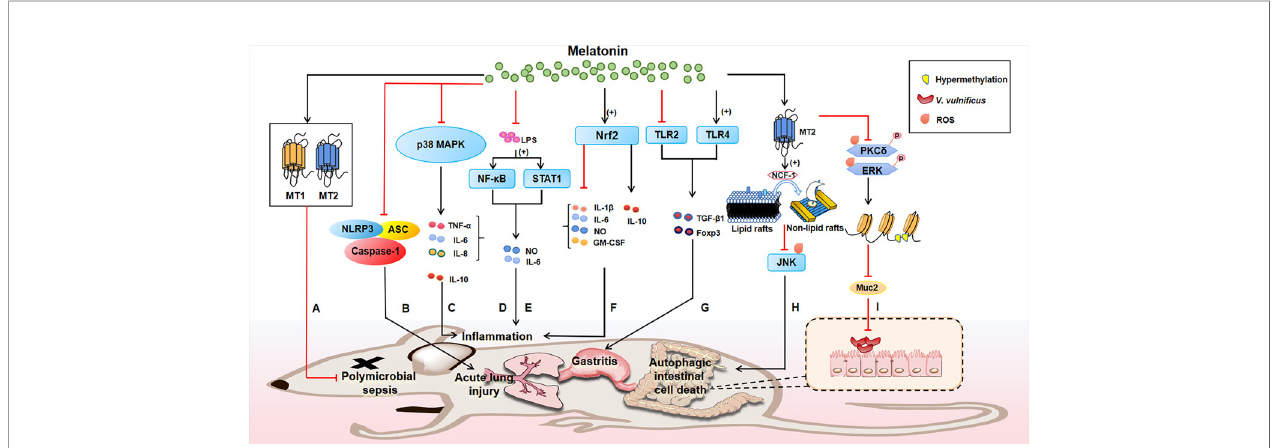
FIGURE 2 | The bacteriostatic mechanisms of melatonin in animals. Melatonin receptors (e.g., MT1 and MT2) play a great role in mediating the functions of melatonin. Melatonin reduces polymicrobial sepsis through MT1 and MT2, thus improving the survival rate of mice (A) ; notably, the mechanisms whereby melatonin exerts bacteriostatic action in vivo are tightly associated with the immune responses, for instance, melatonin inhibits NLRP3 in fl ammasome to alleviate acute lung injury (B) ; melatonin reduces pro-in fl ammatory cytokines, increases anti-in fl ammatory cytokines and improves survival through p38MAPK signaling pathway (C) ; melatonin blocks LPS-induced activation of NF- k B (D) and STAT1 (E) , thus inhibiting the production of in fl ammatory factors to modulate in fl ammation. Likewise, suppression of in fl ammation also occurs when melatonin activates Nrf2, evidenced by reduced pro-in fl ammatory mediators (e.g., IL-1 b , IL-6, NO and GM-CSF) and increased anti-in fl ammatory cytokine (e.g., IL-10) (F) ; melatonin treatment can target TLR to alleviate H . pylori -induced gastritis by promoting TLR4 and inhibiting TLR2 to regulate TGF- b 1 and Foxp3 expression (G) ; of note, melatonin could be a therapeutic alternative agent to fi ght bacterial infections due to its antioxidant function. For example, melatonin signaling via MT2 promotes NCF-1 recruitment from lipid rafts to non-lipid rafts to block the ROS-mediated JNK pathway, preventing autophagic intestinal cell death (H) ; moreover, MT2 signaling inhibits the ROS-mediated phosphorylation of PKC d and ERK to reduce region-speci fi c hypermethylation in the Muc2 promoter, combating V. vulni fi cus infection (I) . Note: plus in parentheses represents increase; and the red line represents inhibition; the black arrow indicates activation.